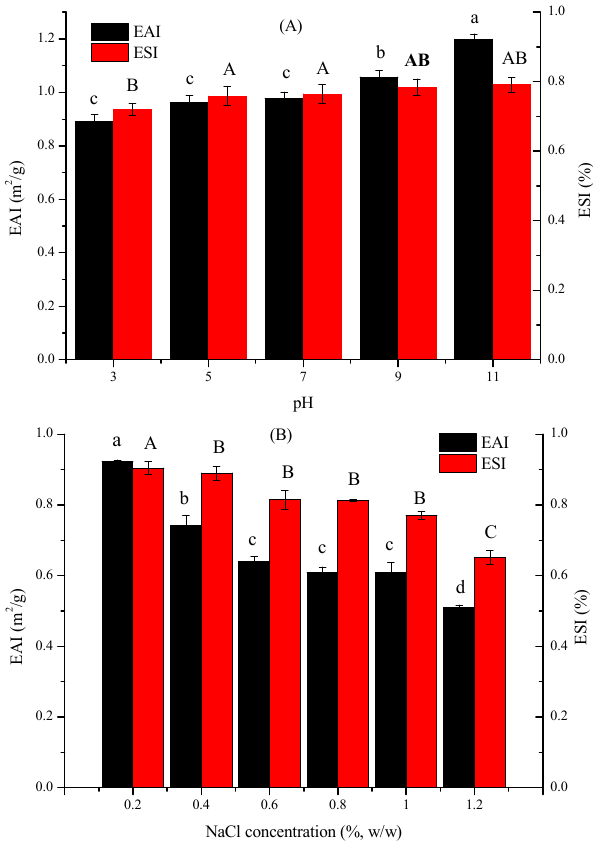
Figure 2. Effect of pH ( A ) and NaCl ( B ) on EAI and ESI. (Different lowercase and uppercase letters indicate a significant difference between EAI and ESI at p < 0.05).